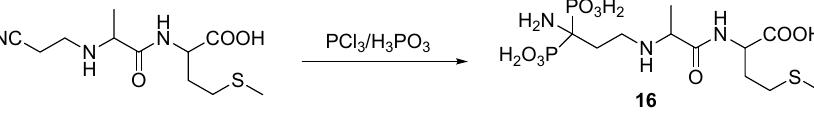
Scheme 9. Representative example of the synthesis of peptidylbisphosphonates from nitriles.